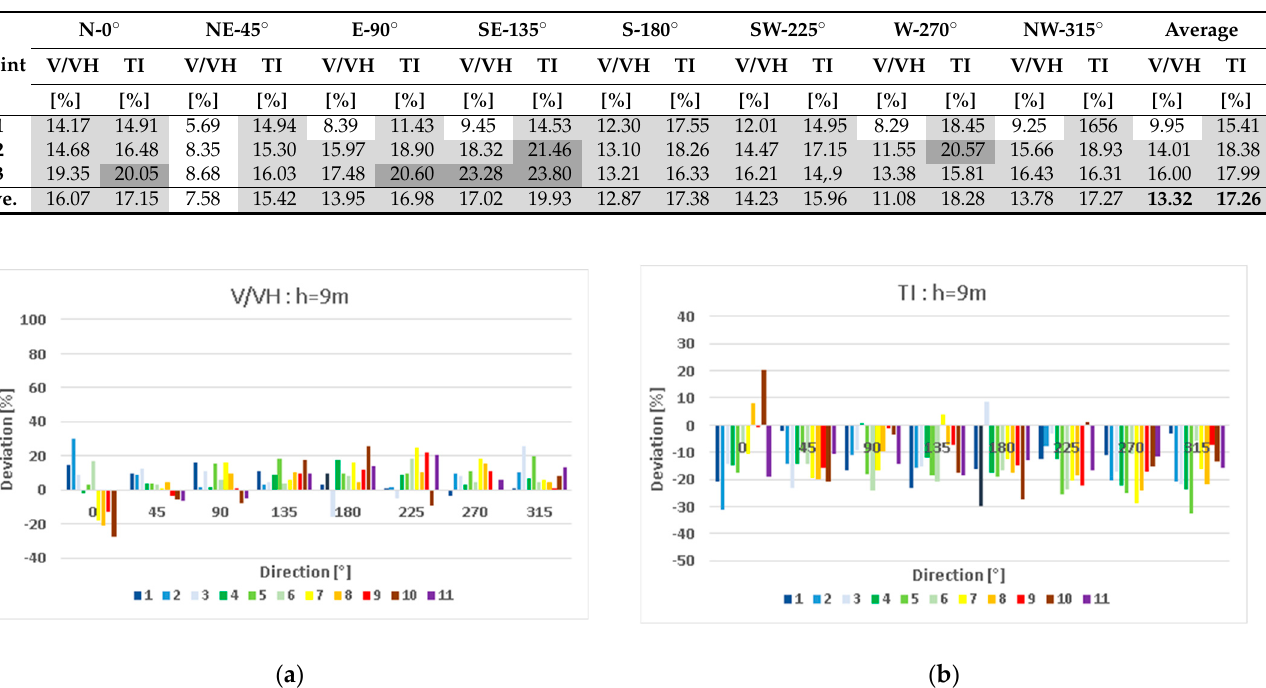
( b ) Figure 26. Mean absolute deviations of the wind ( a ) and turbulence intensity ( b ) per direction for the 11 probe validation points at height h = 12 m with OpenFOAM.